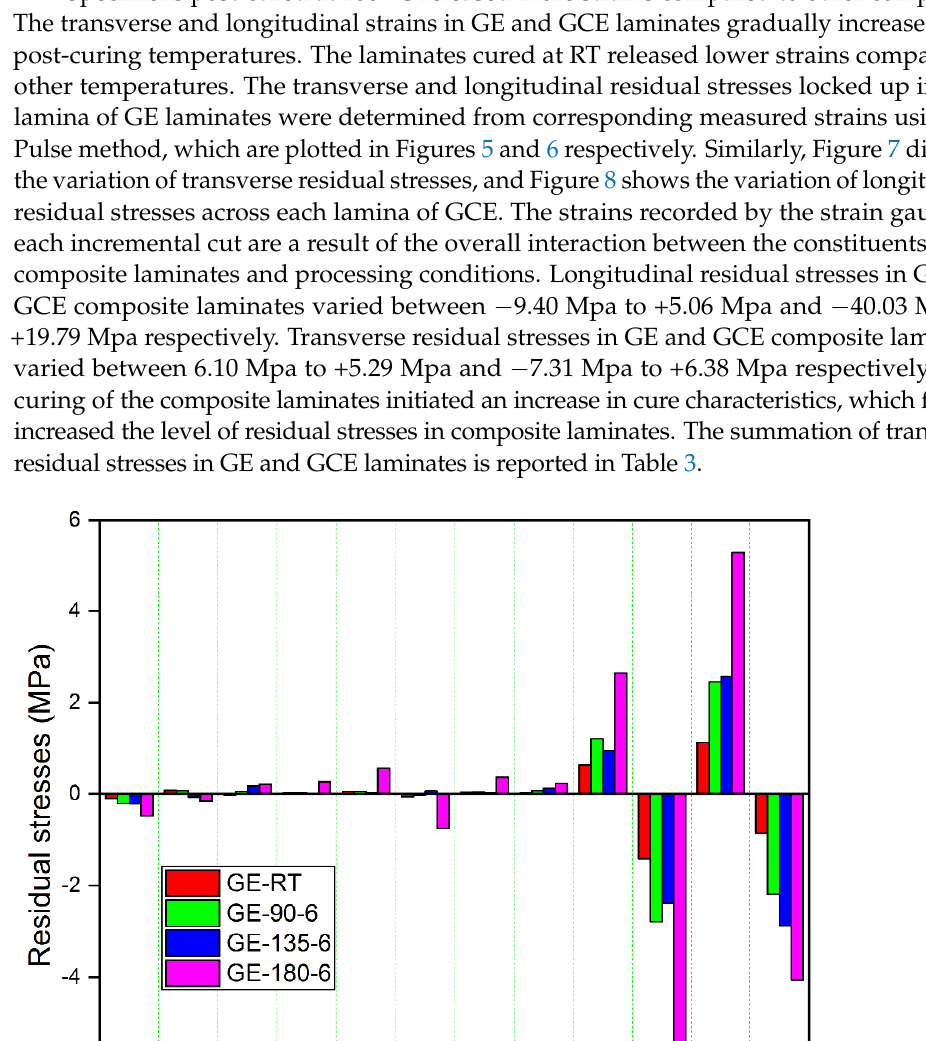
Figure 6. Longitudinal residual stress in each lamina determined from recorded longitudinal strains for all GE laminates.